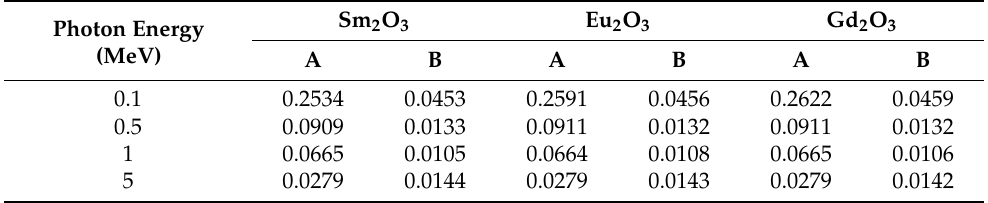
Table 5. Mathematical constants (A and B) of µ in the form µ = Ae Bx (Equation (6)) from Figure 5.